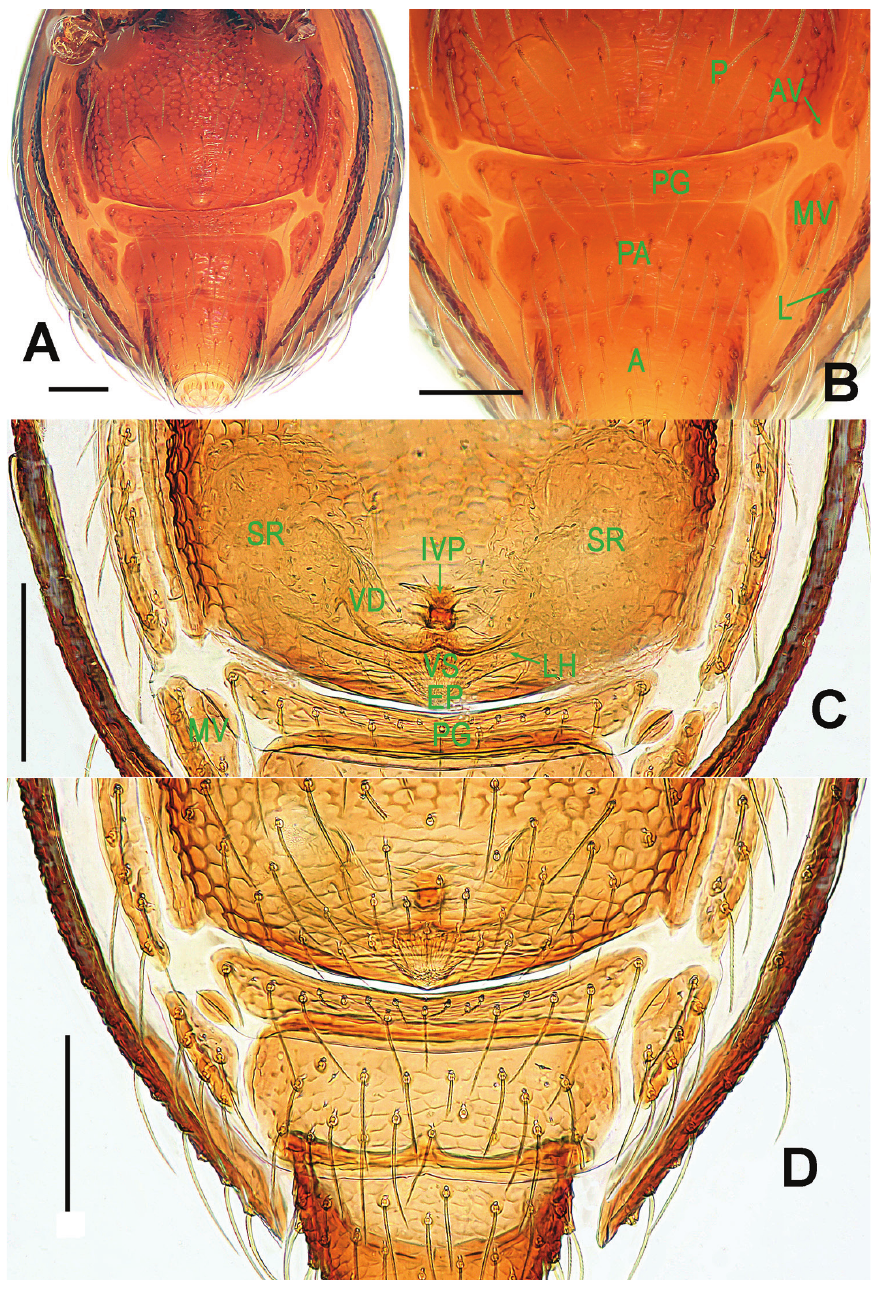
Figure 26. Singaporemma singulare Shear, 1978 , female specimen from Singapore. A opisthosoma B gen- ital area (untreated) C cleared vulva (lactic acid-treated) D ditto . A–B, D ventral C dorsal. Abbreviations: A = anal plate; AV = anterior ventrolateral plate; EP = epigynal pit; IVP = inner vulval plate; L = lateral plate; LH = lateral horn; MV = median ventrolateral plate; P = pulmonary plate; PA = preanal plate; PG = postgenital plate; SR = seminal receptaculum; VD = vulval duct; VS = vulval stem. Scale bars: 0.10